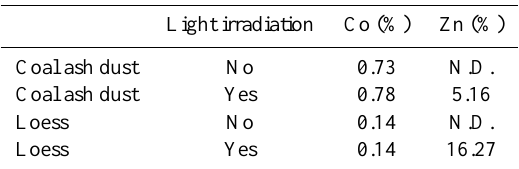
Table 3. Percentage of dissolved metal from initial composition of the dust (cf. Table 2) after 2h of dissolution in seawater.